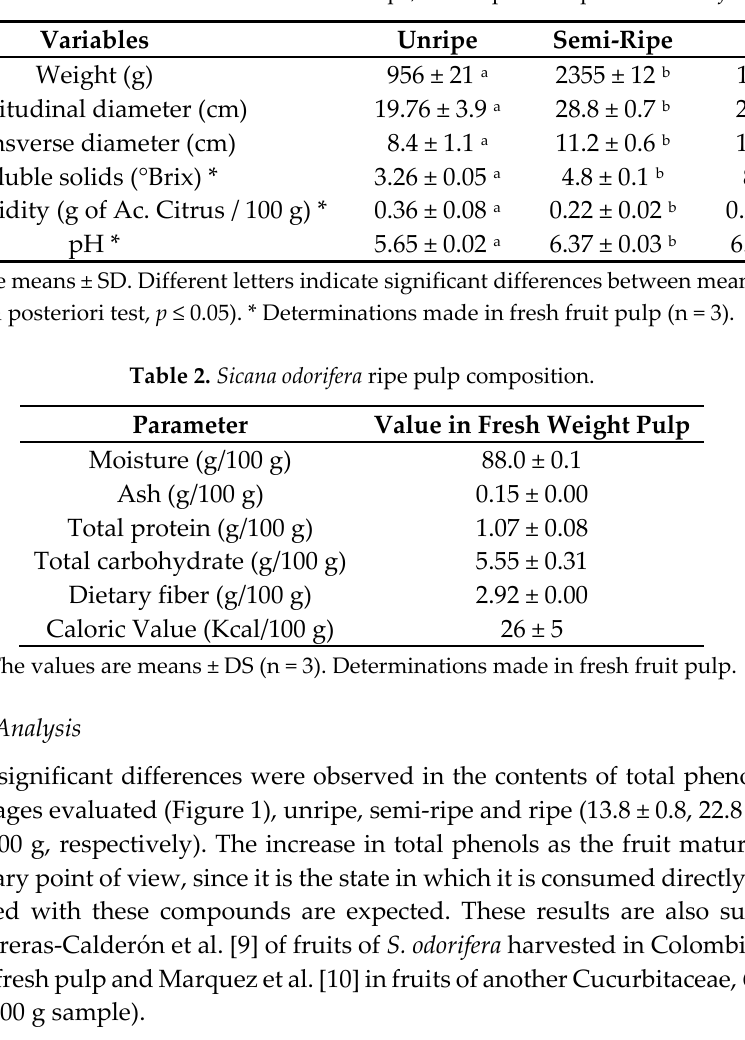
Table 1. Physicochemical characterization of the unripe, semi-ripe and ripe Sicana odorifera fruit pulp.